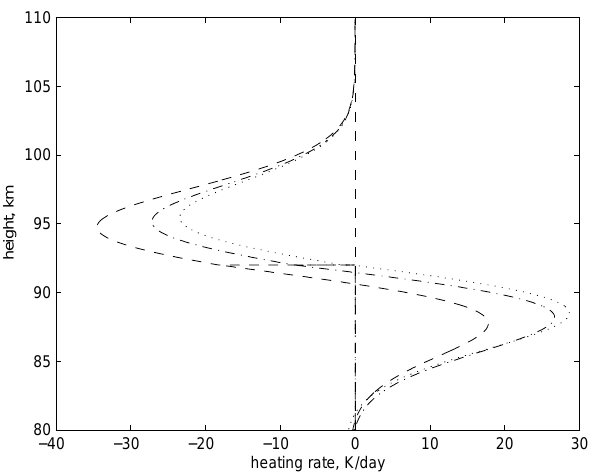
Fig. 3. Heating by eddy turbulence calculated with Ri =0.8 (dashed line), Ri =0.4 (dashed-dotted line), and Ri =0.3 (dotted line) plus other parameters: K 0 ec = 2 × 10 4 cm 2 s − 1 , K m ec = 2 × 10 6 cm 2 s − 1 , S 1 = 0 . 02km − 1 , S 2 = 0 . 04km − 1 , S 3 = 0 . 02km − 2 , T 0 = 211K. The vertical line shows the K ec peak altitude.